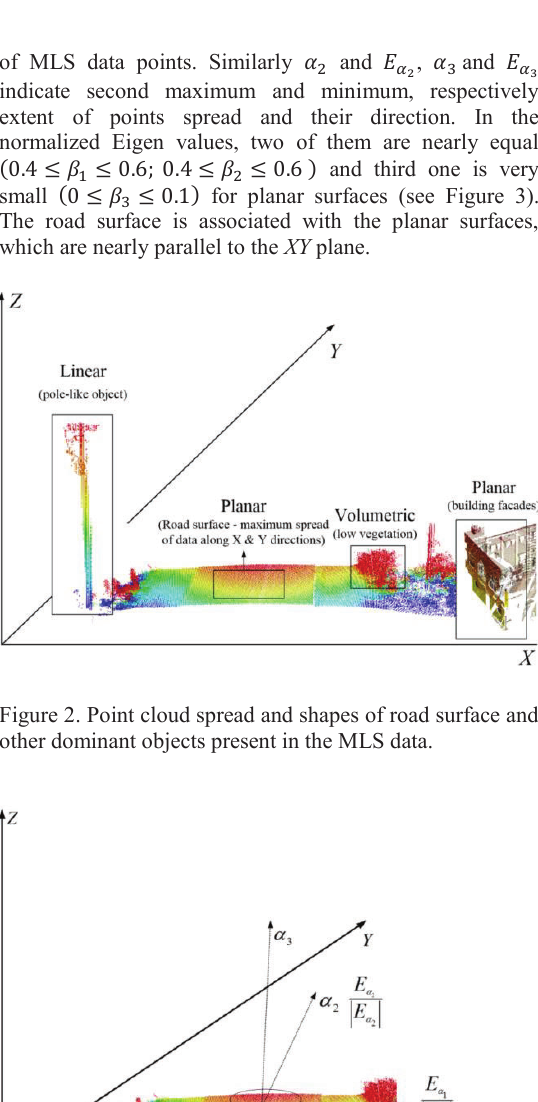
Figure 3. Eigen values and Eigen vectors, which represent road surface MLS data